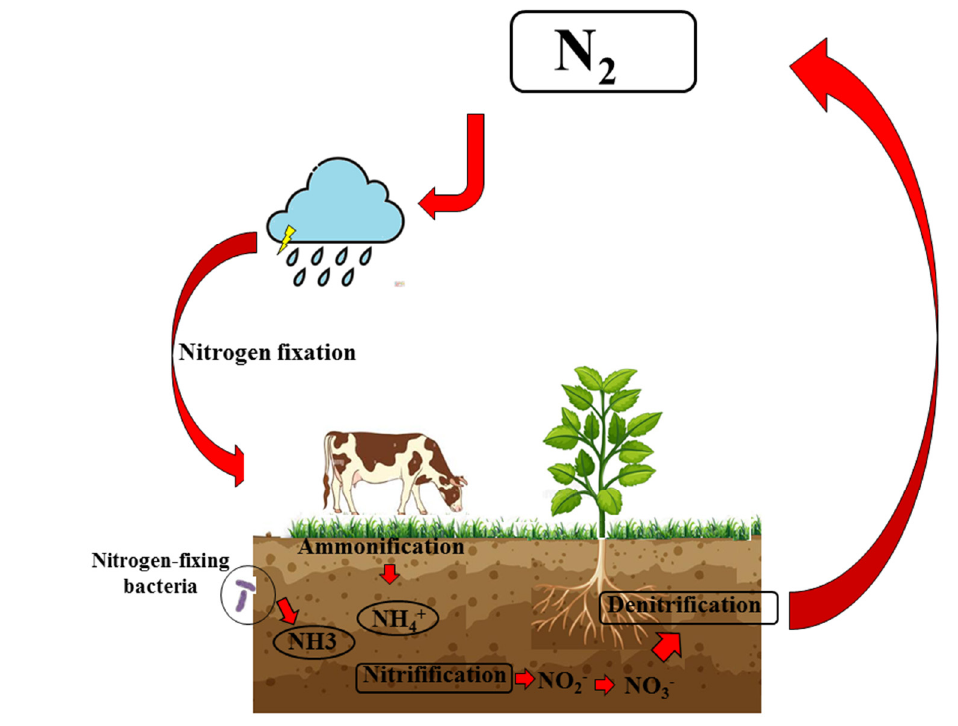
Figure 3. Biogeochemical nitrogen cycle. The difficult assimilation of N2 makes it necessary to organify nitrogen. The first step is known as “nitrogen fixation”, in which N 2 is made available as ammonia (NH 3 ). A subsequent process known as “ammonification”, carried out by fungi and various soil bacteria, is responsible for the formation of the ammonium ion (NH 4+ ). Subsequently, this ion can be nitrified by some bacteria free in the soil, which generate nitrites and nitrates. Nitrates represent the most bioavailable form of nitrogen for plants, and they are absorbed at a radical level, transformed into vegetable proteins, and used as a source of nitrogen for the whole trophic network. The nitrogen cycle ends with the “denitrification” phase, in which some bacterial species again lead to the formation of N 2 .